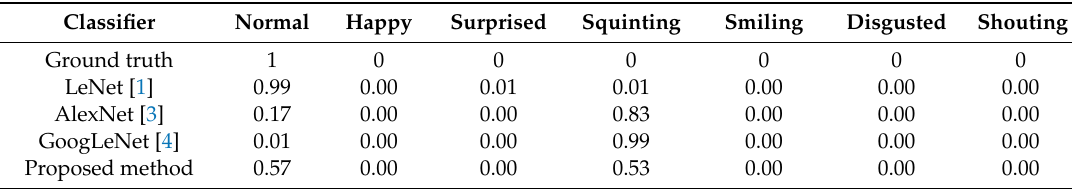
Figure 13. Multi-PIE database example photo (1)-360. Table 13. Example photo (8)-135 recognition